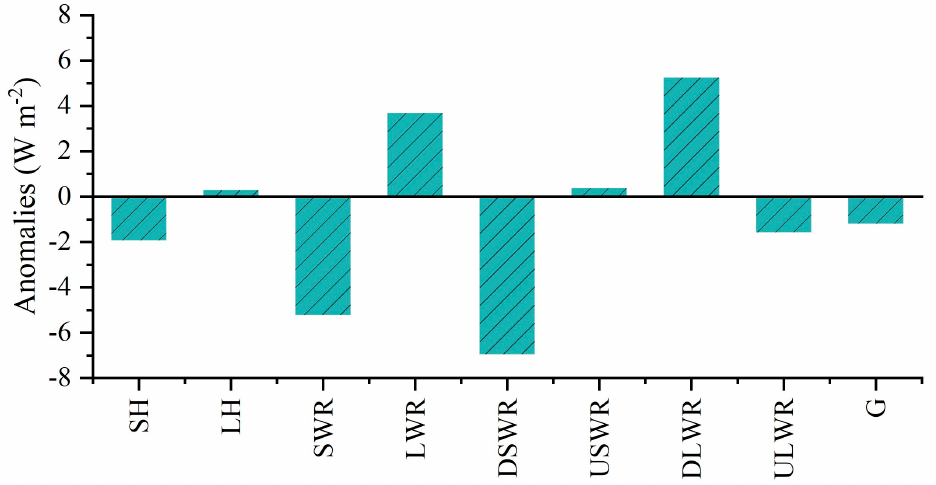
Figure 4. The difference in SH, LH, SWR, LWR, DSWR, LSWR, DLWR, ULWR, and G between 1997–2018 and 1981–1995 over the TP (W m − 2 ).